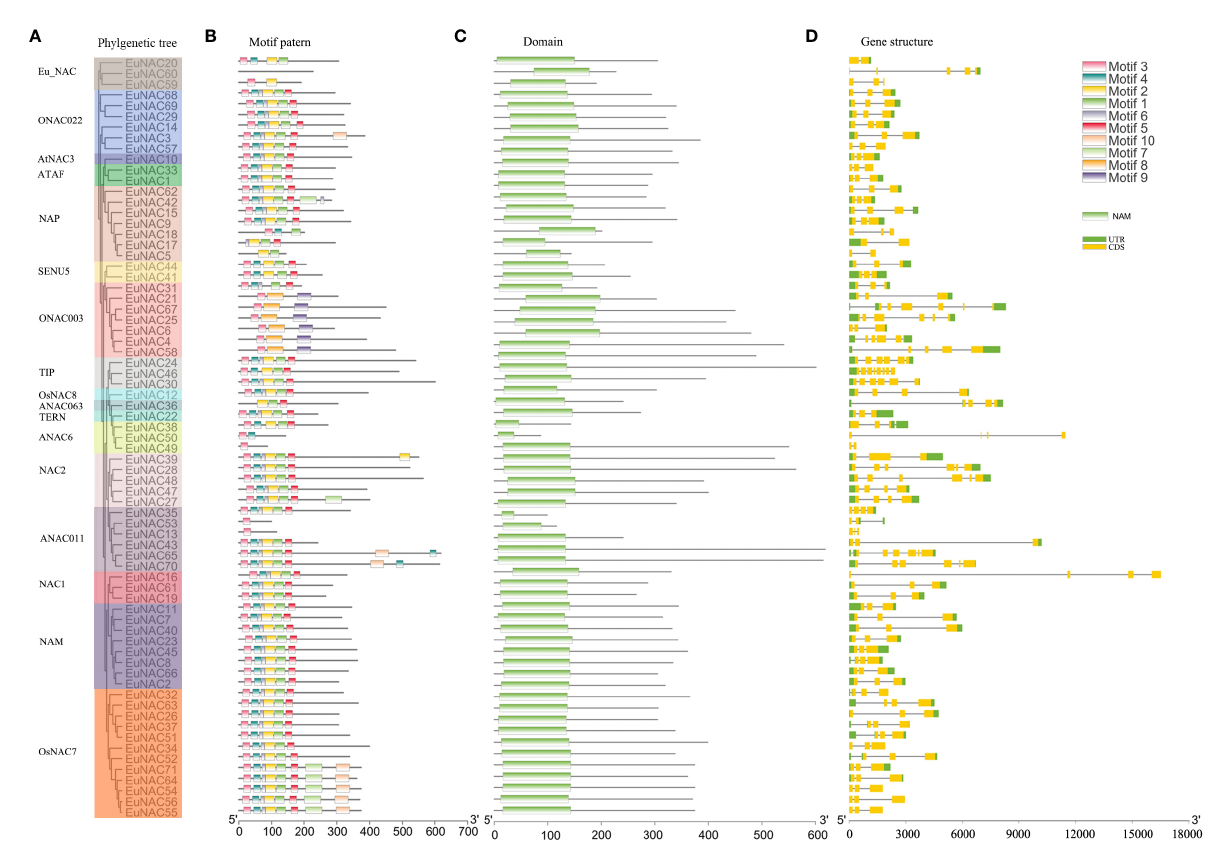
FIGURE 2 Phylogenetic relationships, domin, gene structure and architecture of conserved protein motifs in NAC genes from E. ulmoides . (A) Estimated phylogeny of EuNAC genes. (B) Different motifs were represented by diferent colors. The black lines represented the non-conserved sequences. Lengths of motifs for each EuNAC protein were displayed proportionally. (C) NAC domains were represented by green. (D) UTR were represented by green, CDS were represented by yellow. Nucleic acid lengths are indicated by the scale at the